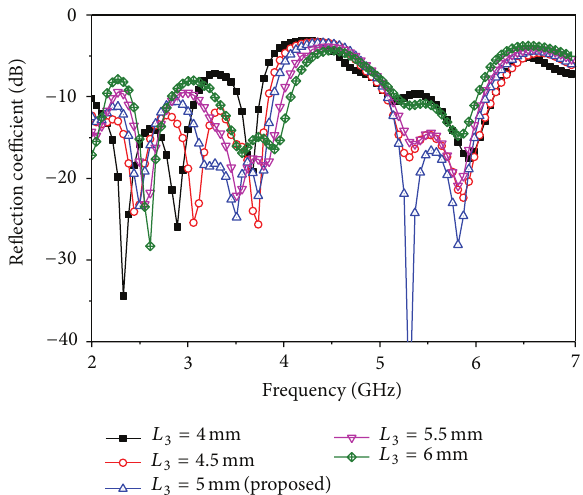
Figure 4: Effect of reflection coefficient for the different width of patch slot 𝐿 3 .